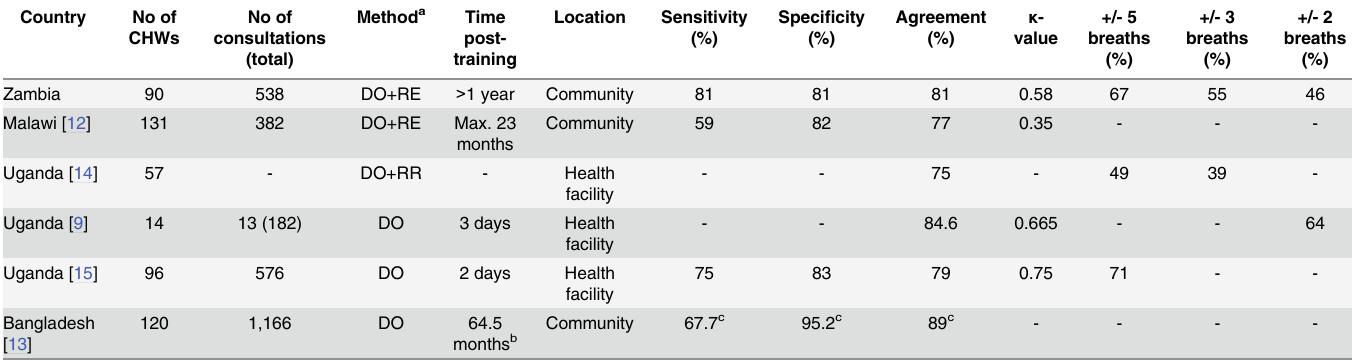
Table 4. Comparison of data with literature on CHW performance in measuring respiratory rate.